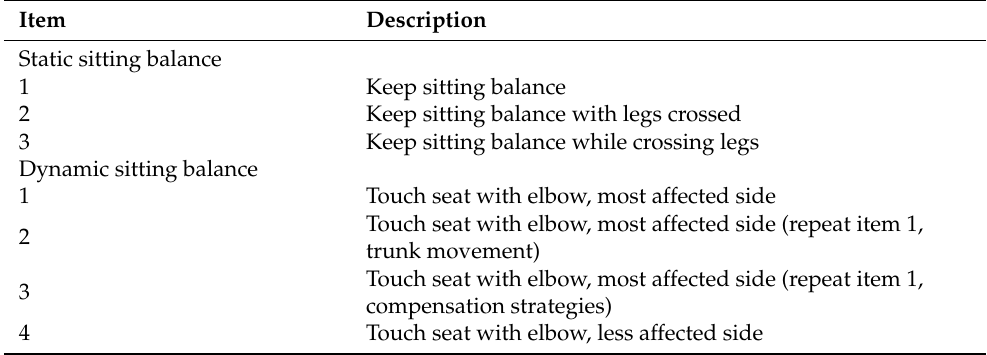
Table 2. Summary of the items of the Trunk Impairment Scale